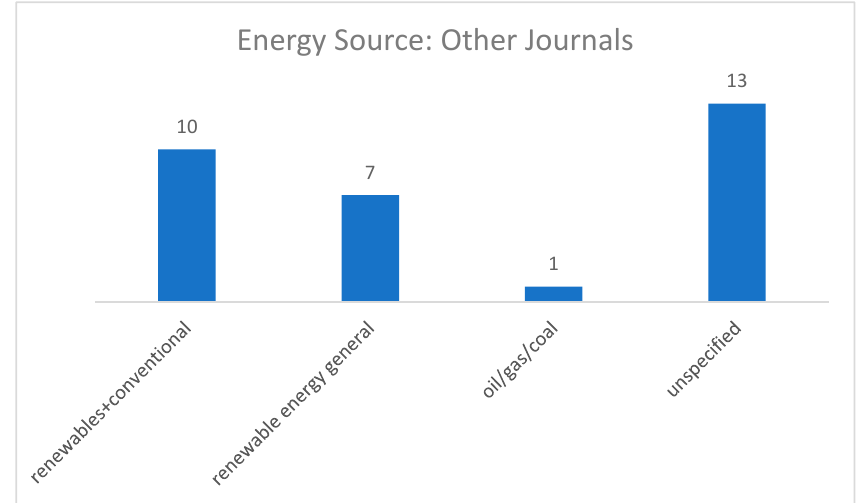
Figure 4. Number of influential articles by type of energy source.